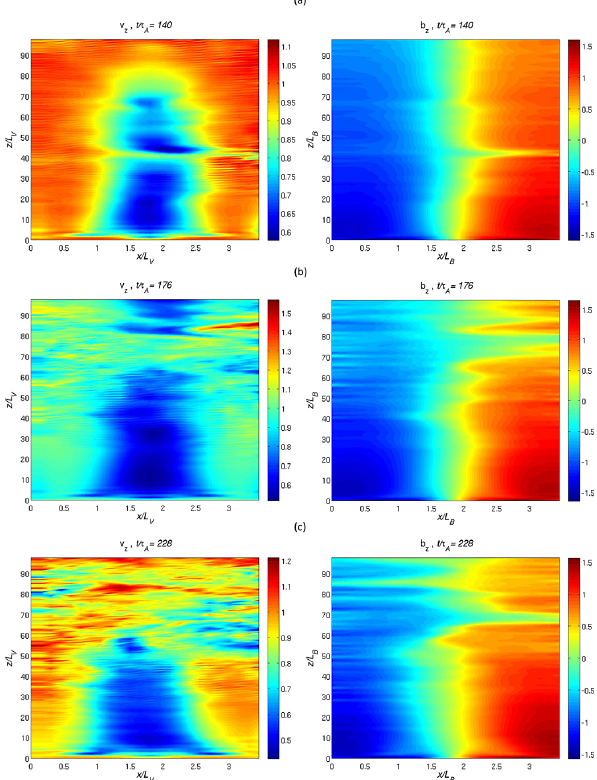
Fig. 12. z components of the solar wind velocity v z (left panel) and of the magnetic field b z (right panel) of the reference simulation in correspondence with doi plots of Fig. 11, for times (a) t/τ A = 176, (b) t/τ A = 140 and (c) tτ A = 228. The spatial dimensions are nor- malised to L v = L B , the length scales of variation of the magnetic field and of the velocity; time is normalised to the Alfvén time τ A . b z is normalised to b 0 and v z is normalised to the Alfvén speed v A